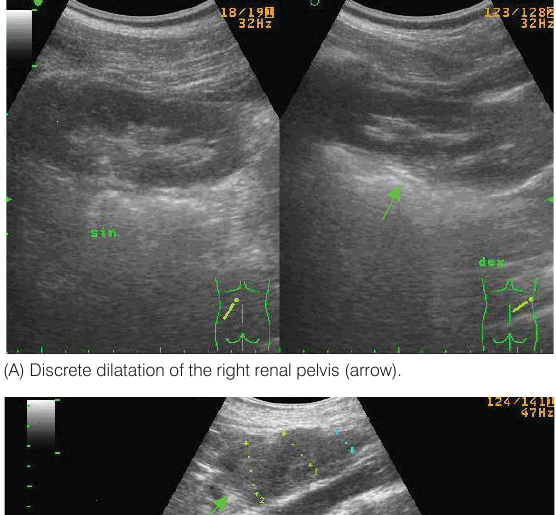
Figure 1. Abdominal echography scan performed in May